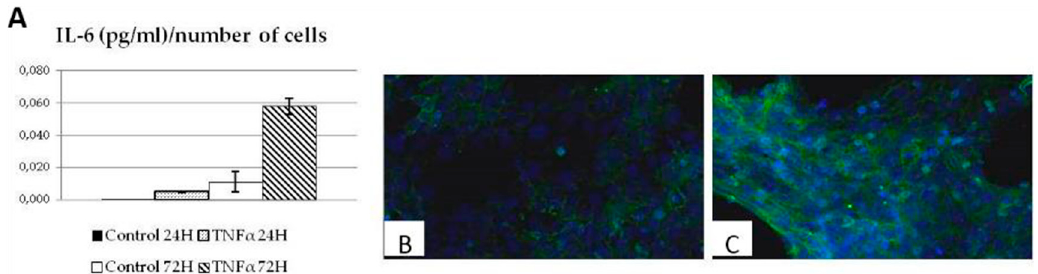
Figure 1. ( A ) Quantification of IL-6; ( B ) CD44 receptor in control; and ( C ) in inflamed HCE cells.